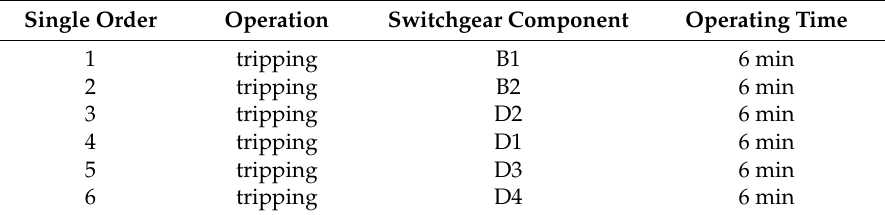
Figure 7. The IEEE Reliability Test System-1979. Table 1. Dispatching order.